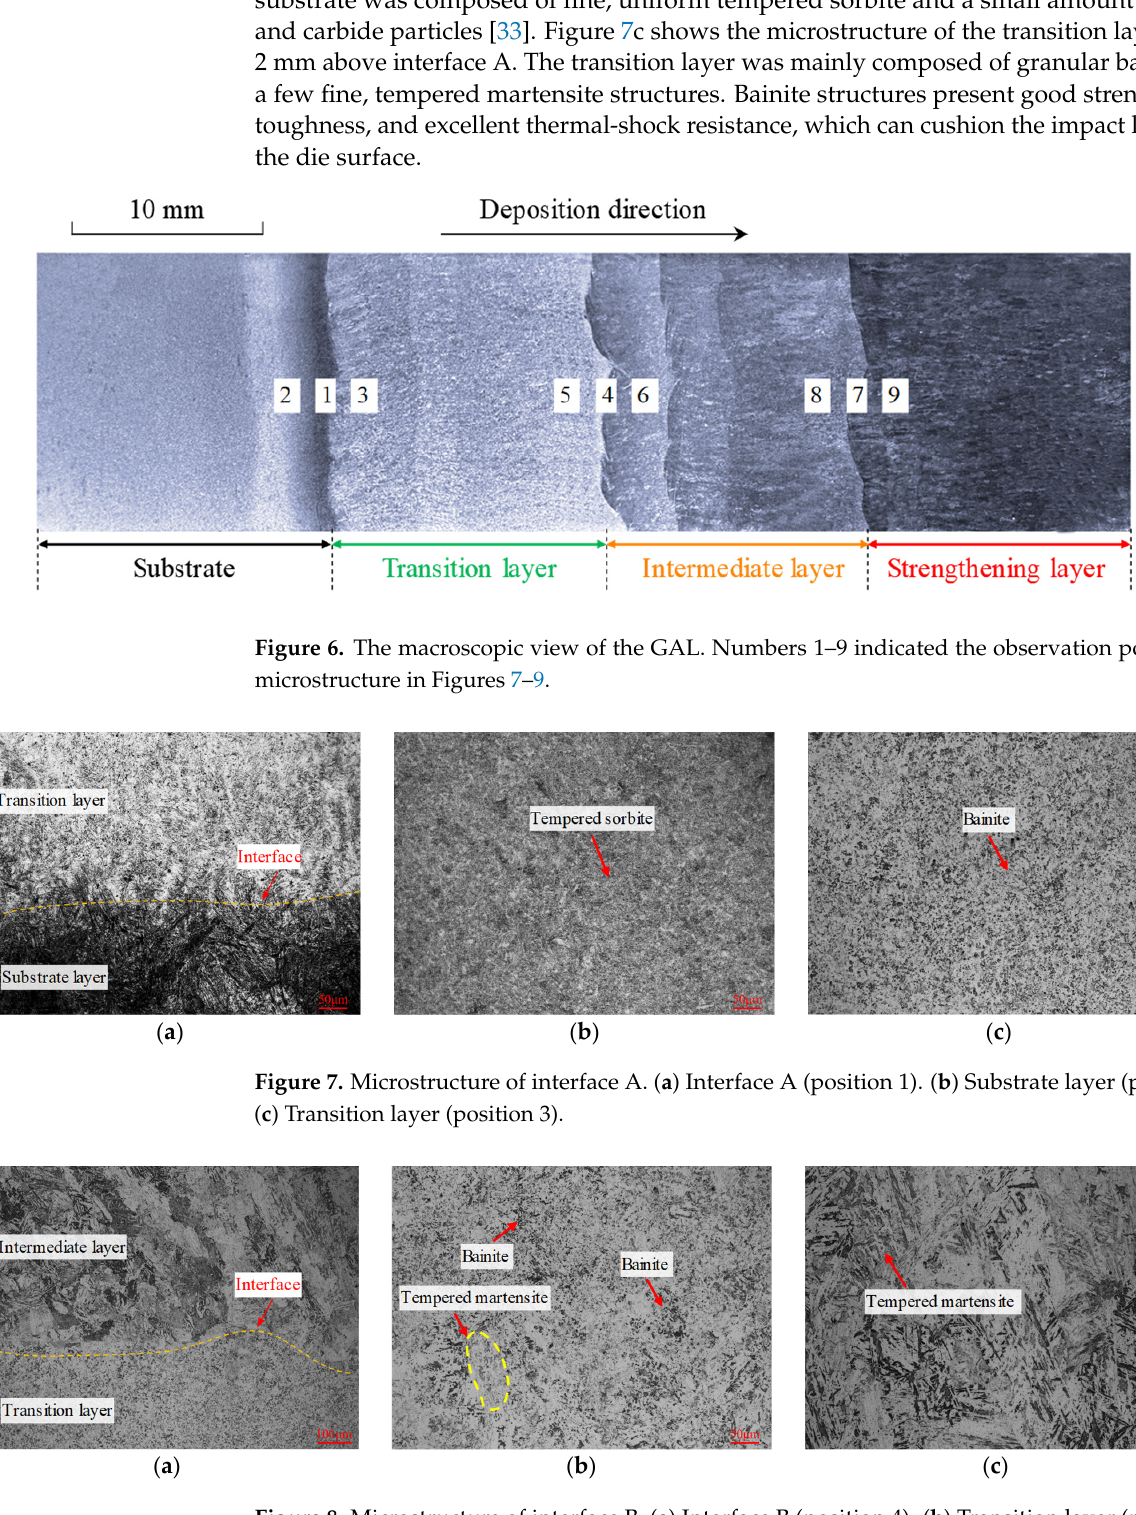
( c ) Figure 8. Microstructure of interface B. ( a ) Interface B (position 4). ( b ) Transition layer (position 5). ( c ) Intermediate layer (position 6).